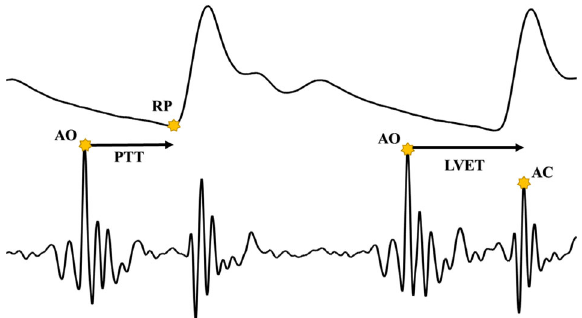
Fig. 2 Blood pressure and seismocardiogram waveforms with annotations. Pulse Transit Time (PTT) is the time interval between the aortic valve opening (AO) peak of SCG and RP (Foot) of BP. LVET is the time interval between the AO and AC peak of the